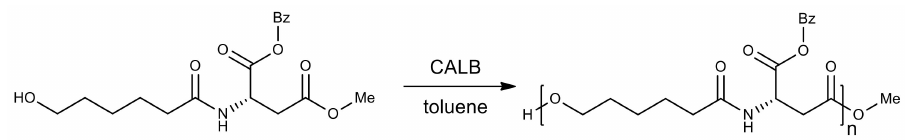
Figure 11. CALB-catalyzed polymerization of N-(6-hydroxyhexanoyl)-L-aspartate. The polymerization of 2,5-furandicarboxylic acid, one of the key building blocks